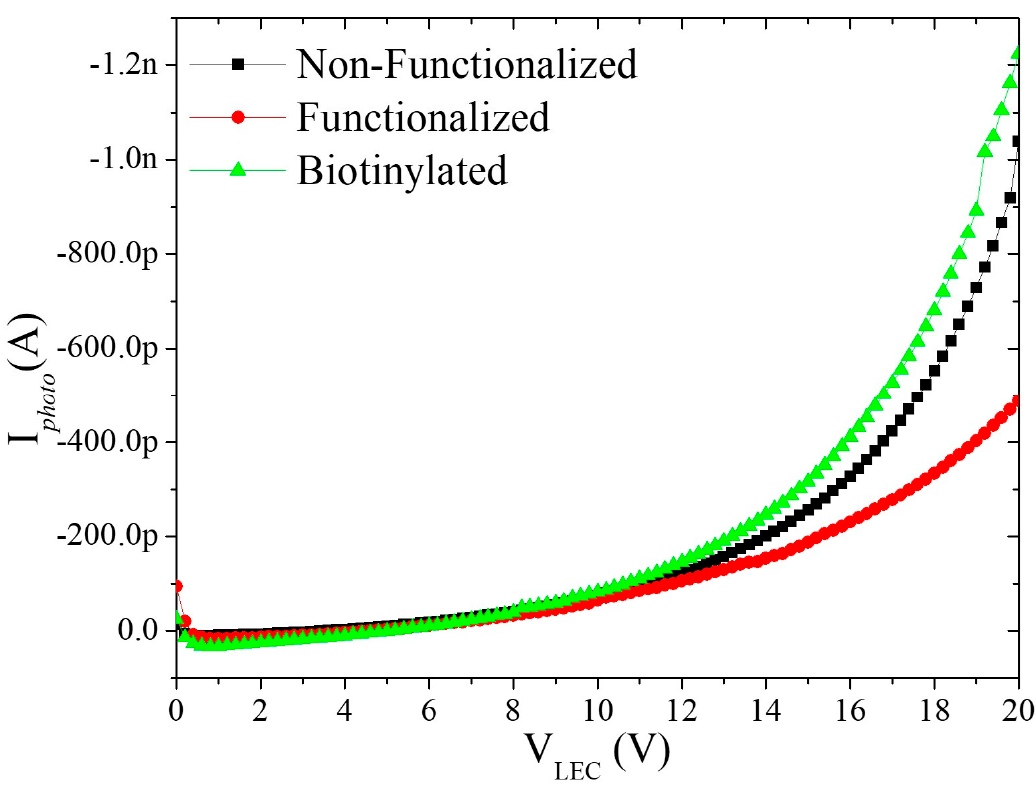
Figure 5. Measured photocurrent I photo of the Eph circuit of the non-functionalized WG, after the functionalization process and after biotinylation.